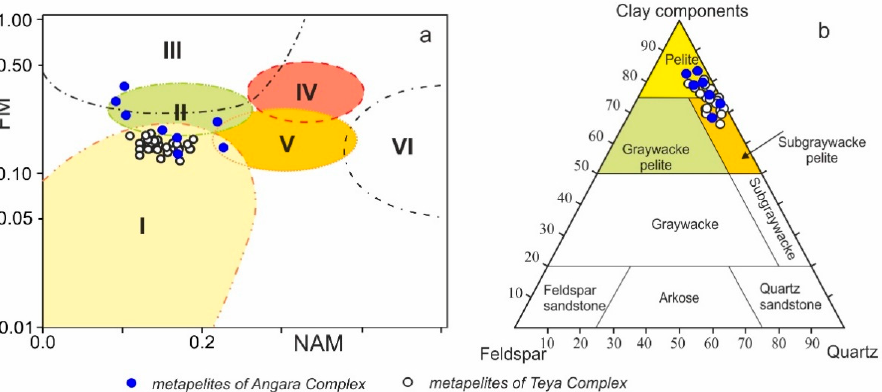
Figure 36. ( a ) Data points of Teya Group metapelites plotted in the FM-NAM module diagram [129]. FM is represented on a logarithmic scale. Predominent clay minerals in the fields are: I—kaolinite; II—montmorillonite with minor abundance of kaolinite and hydromica; III—chlorite with minor abundance of Fe-hydromica; IV—chlorite and hydromica; V—chlorite, smectite, and hydromica; VI—hydromica with an appreciable amount of potassium feldspar. ( b ) MINLITH—normative composition of metapelites on a feldspar (plagioclase + orthoclase)—clay minerals (montmorillonite + illite + chlorite + kaolinite)—quartz triangular plot [130].